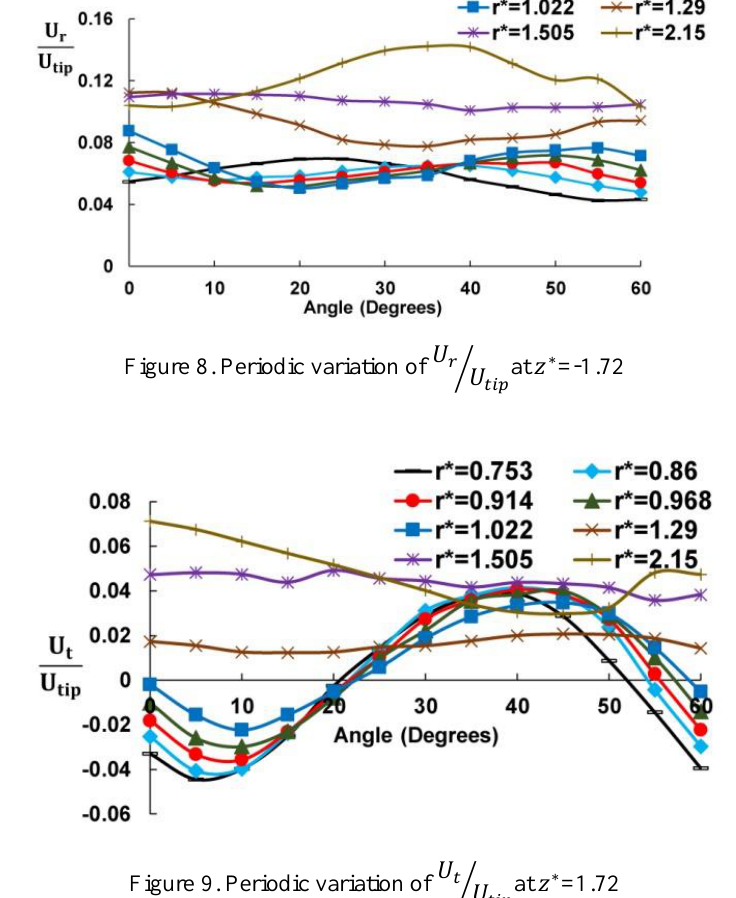
Figure 9. Periodic variation of